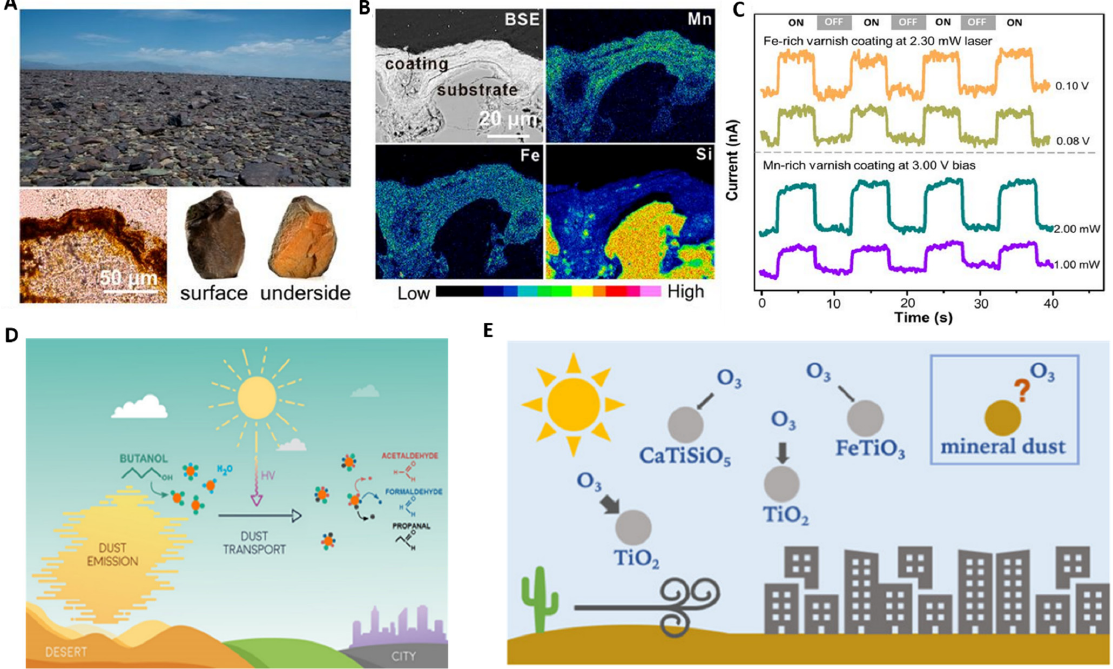
Figure 1. ( A – C ) Structure and catalytic properties of minerals: composition of ferromanganese ore and photoelectrical properties, copyright PNAS. ( D ) adsorption, migration, and photocatalytic oxidation of VOCs by mineral particles in air, copyright 2018 American Chemical Society. ( E ) photocatalytic decomposition of ozone in urban air by titanite dust, copyright 2020 American Chemical